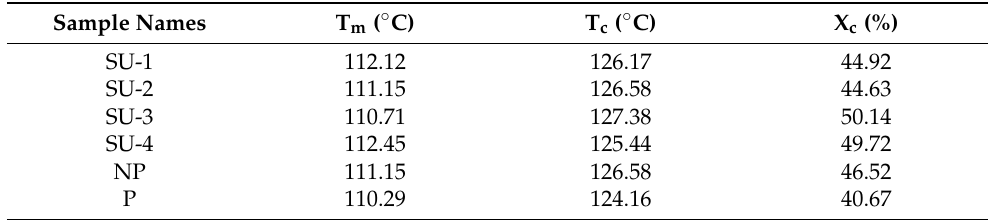
Table 6. Melting temperature, crystallization temperature, and crystallinity of each sample according to the differential calorific scanning (DSC)